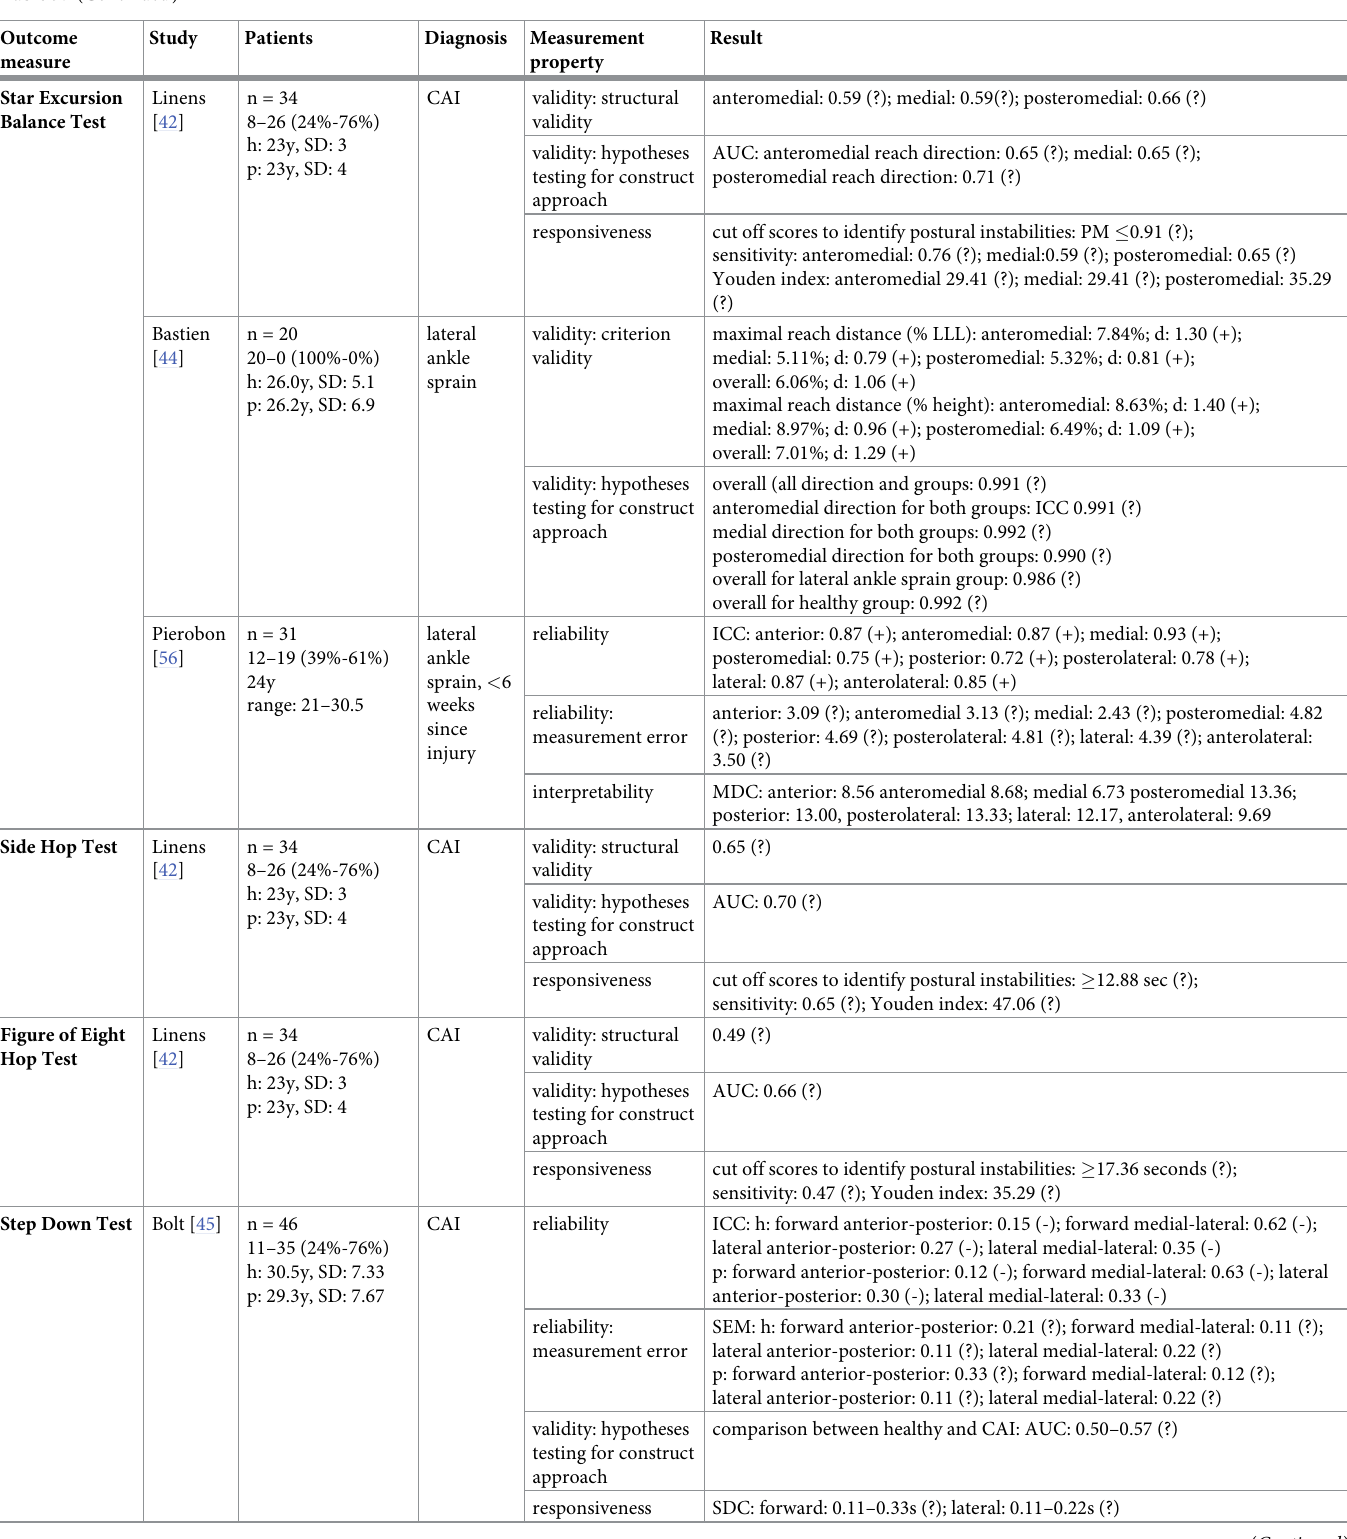
Figure of Eight Hop